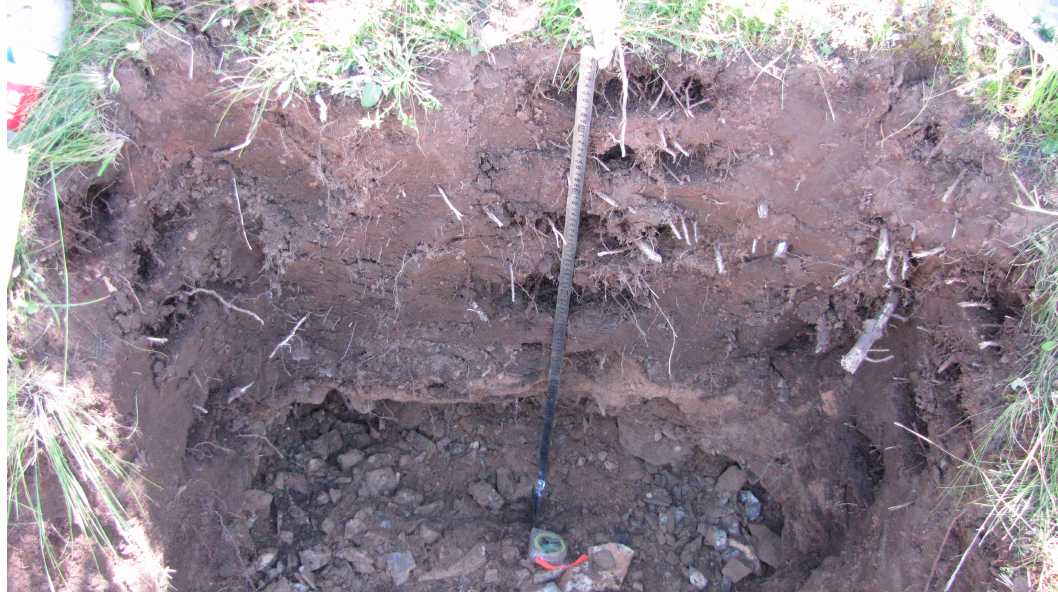
Figure 2. Plot 1 m (length) × 1.5 m (width) × 1 m (height), for collecting soil samples used for soil nitrogen density and bulk density analysis measurement.